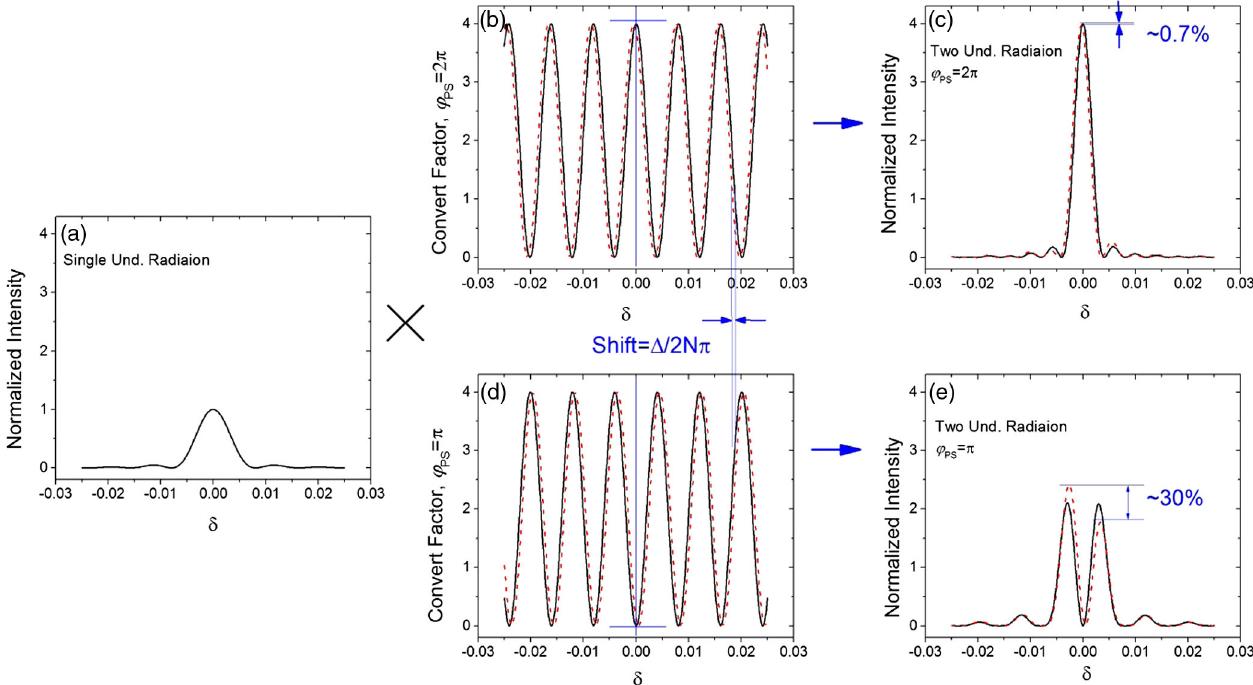
FIG. 11. The on-axis radiation spectrum from two undulators. (a) Single undulator spectrum. (b) Conversion coefficient, Eq. (17). 2 π . Red curve: Δ ¼ 20 degrees. (c) Two undulator spectrum, product of (a) and (b). There is Black curve: Phase shifter set to φ PS ¼ marginal difference for Δ ¼ 20 degree. (d) Conversion coefficient, Eq. (18). Black curve: Phase shifter is set to φ undulator spectrum, product of (a) and (d). Now there is a clear difference for Δ ¼ 20